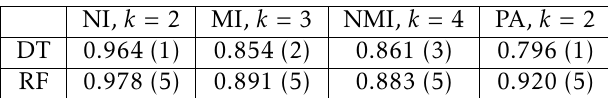
Figure 2. Means and standard deviations of the data type-specific data-sharing willingness levels w , under the four different nudging conditions, shown as error bar charts. Table 9. Prediction accuracy of classifiers trained with a reduced number of important features only. The number within brackets indicates the reduced number of features